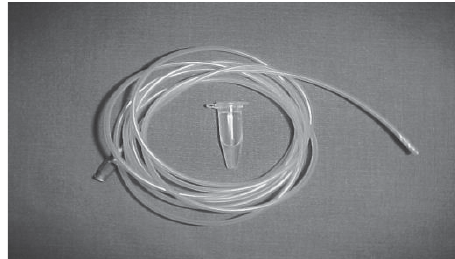
Figure 4 - Catheter for sampling ependdorff